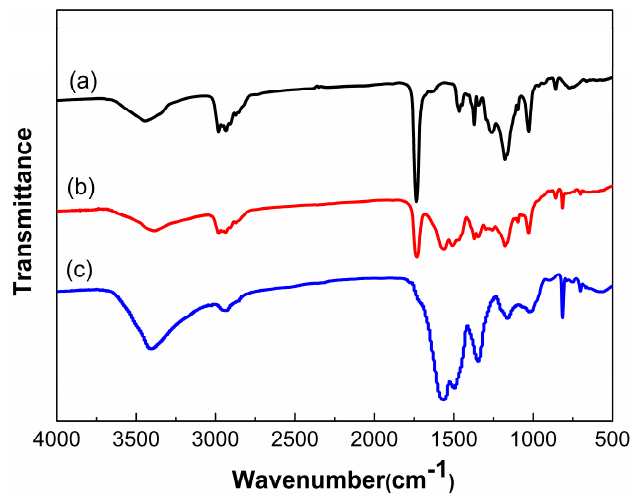
Figure 8. FTIR spectra of ( a ) PAE; ( b ) microencapsulated PAE and ( c ) MF shell.